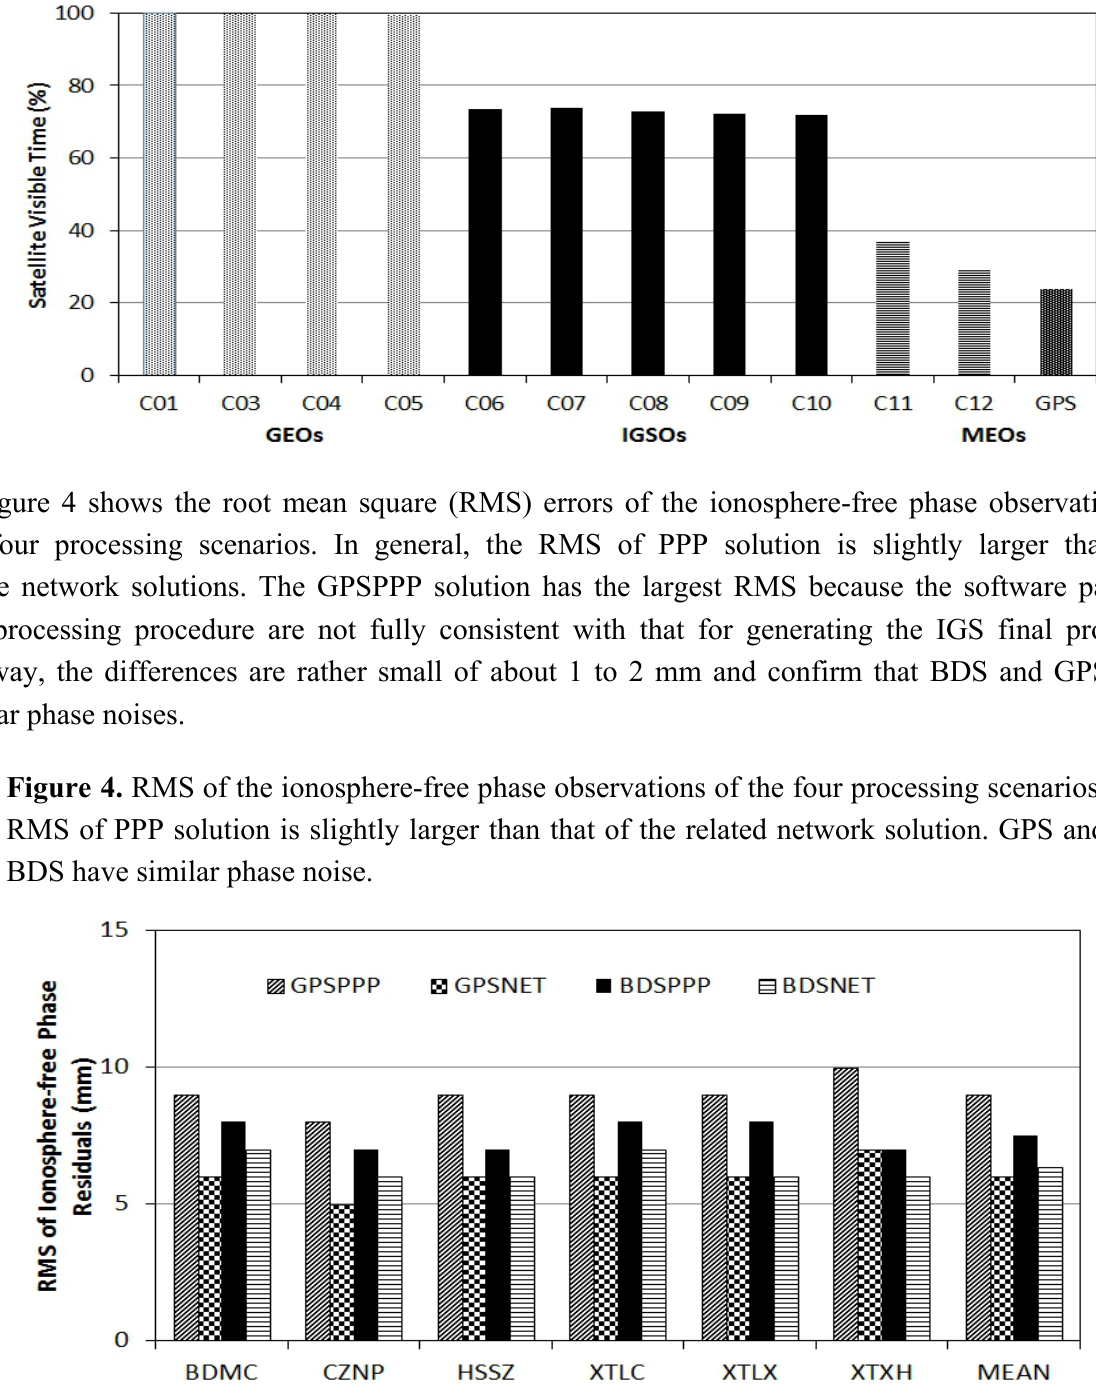
Figure 3. Satellite visibilities in percentage of time for the local network. The GEOs are observed all the time, for IGSO and MEO the averaged visible windows are 73% and 33%, respectively. For GPS satellites the averaged visible time is about 25%.